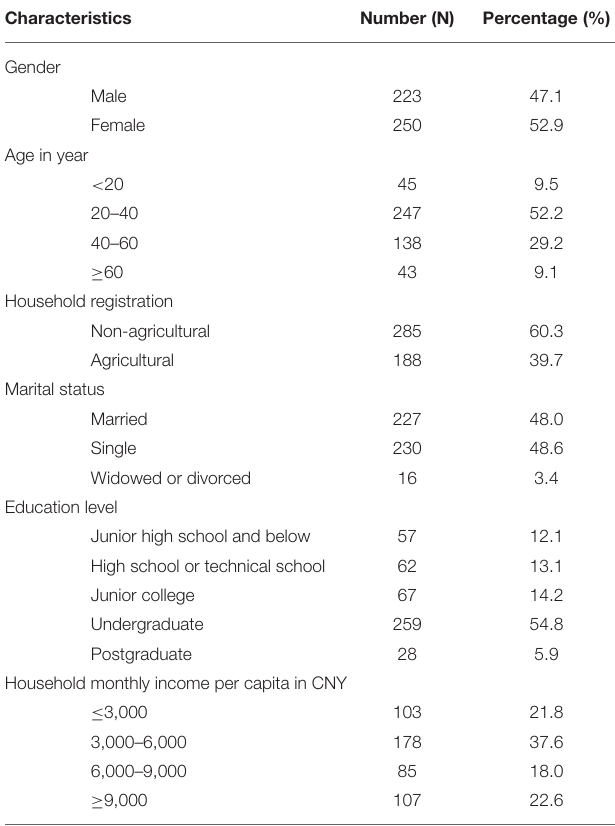
TABLE 2 | Basic characteristics of participants in this